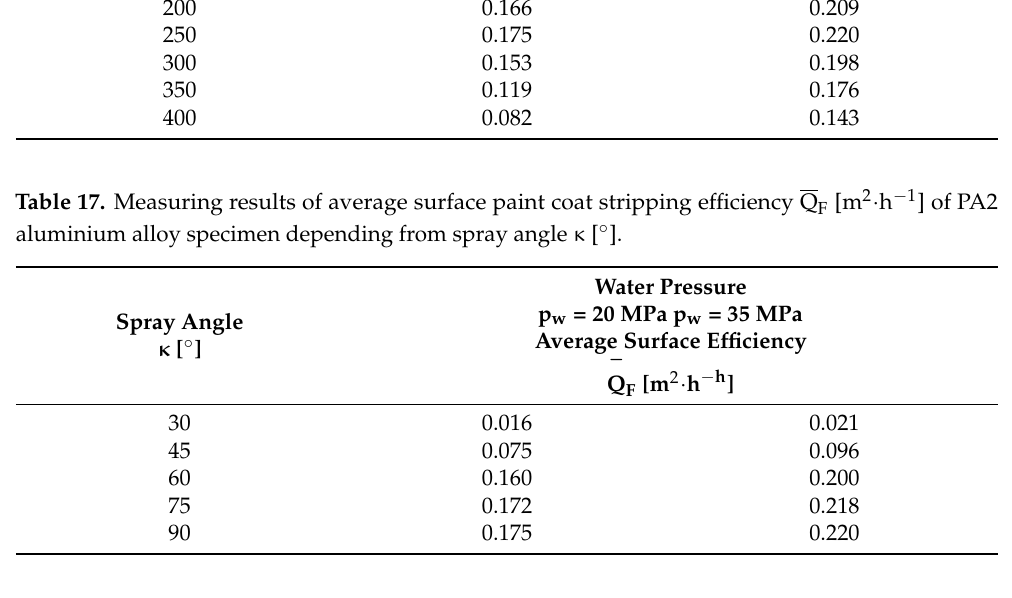
Table 18. Measuring results of average surface paint coat stripping efficiency Q F [m 2 · h − 1 ] for central . values m L = 156 [kg · h -1 ], l 2 = 250 [mm], κ = 90 [ ◦